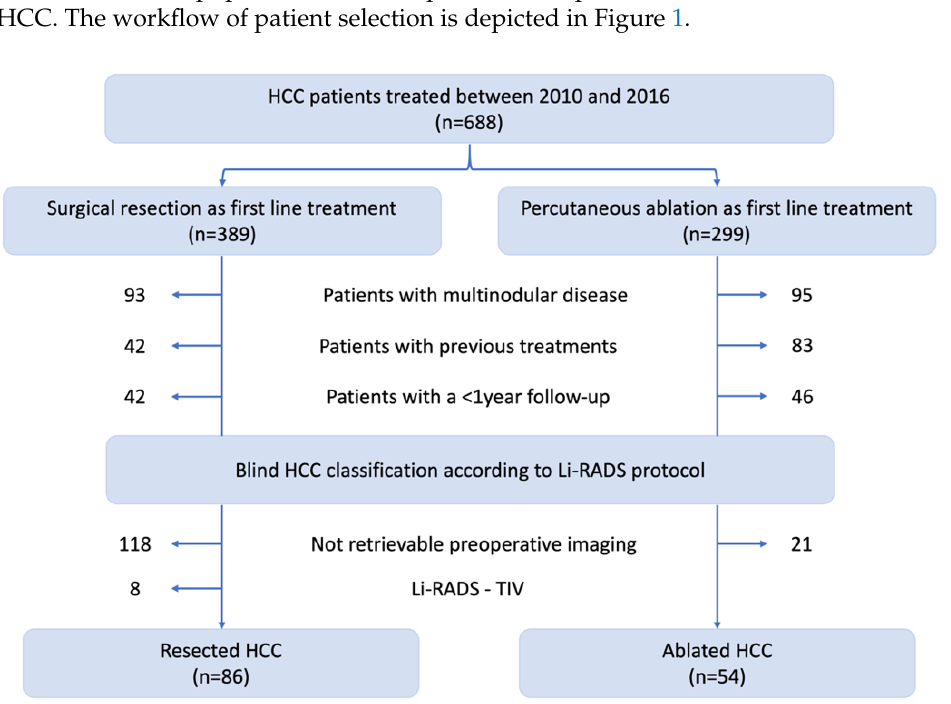
Figure 1. Flowchart for patient selection.